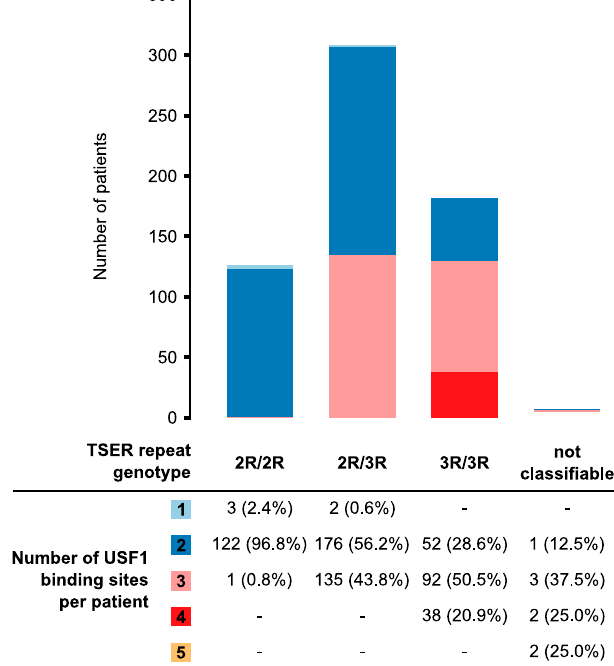
Figure 2. Number of USF1-binding sites per TSER-repeat genotype. Patients were classified according to the number of repeat elements. The number of USF1-binding sites per patient was subsequently determined. Eight patients carried alleles with more than three repeat elements and could therefore not be assigned to a 2R-3R genotype.